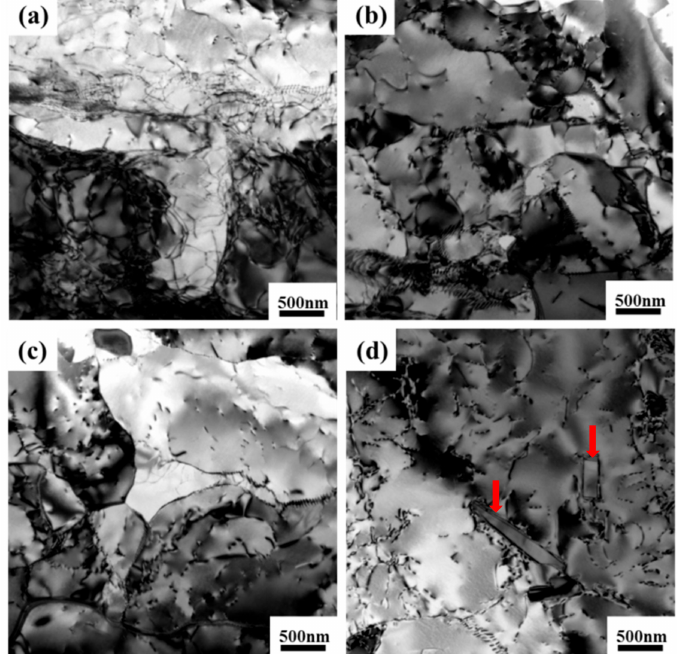
Figure 5. TEM bright field images of aluminum alloys after hot compression: ( a ) 5083, ( b ) 5083 + 0.03 wt.% V, ( c ) 5083 + 0.05 wt.% V and ( d ) 5083 + 0.10 wt.%